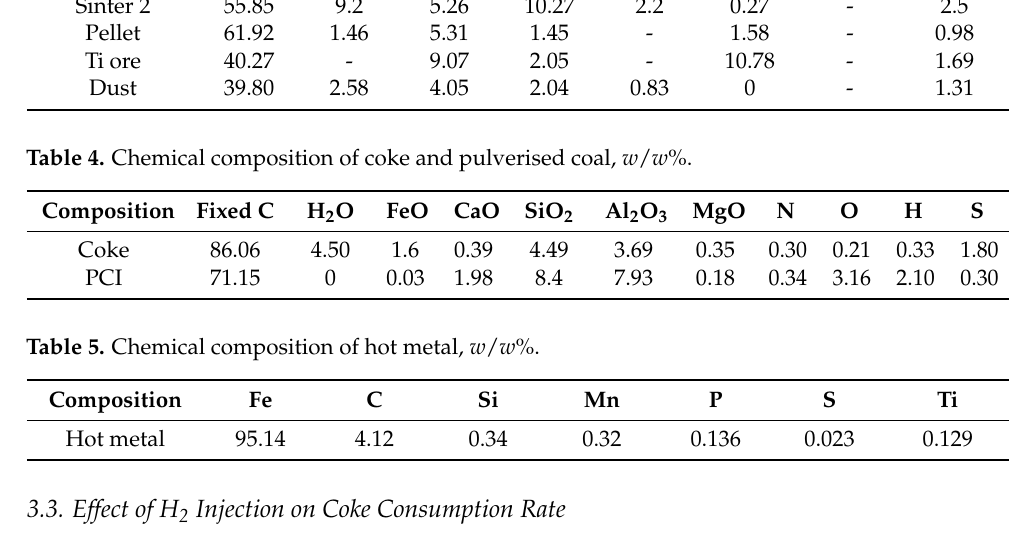
Figure 7. Coke consumption rate at different H 2 injection volumes at different oxygen enrichment rates for thermal compensation. RAFT was maintained at 2096 ° C in this test. 3.4. Effect on H 2 Utilisation Efficiency In the case of injecting H 2 to hearth, bosh gas composition is shown in Figure 8a. As the H 2 injection rate increased from 0 to 160 m 3 /tHM at a constant CO injection rate, CO content in bosh gas drops due to less coke consumption. N 2 content also decreased since less hot blast is required for carbon combustion. There was no H 2 O in the bosh gas be- cause H 2 O that formed from the iron oxide reduction by H 2 reacted with coke to gener- ate H 2 again at high temperature. The amount of top gas and its composition is de- scribed in Figure 8b. With more H 2 injection, the moisture content in the top gas increas- es slightly from 2.72% to 3.12% when the H 2 injection rate reaches from 0 to 100 m 3 /tHM. This is because H 2 utilisation efficiency significantly dropped from 72.6% to 22.9%, as shown in Figure 9a. CO content in top gas decreased because of less CO in the bosh gas and increased CO utilisation efficiency. CO 2 concentration was reduced by less than 2%